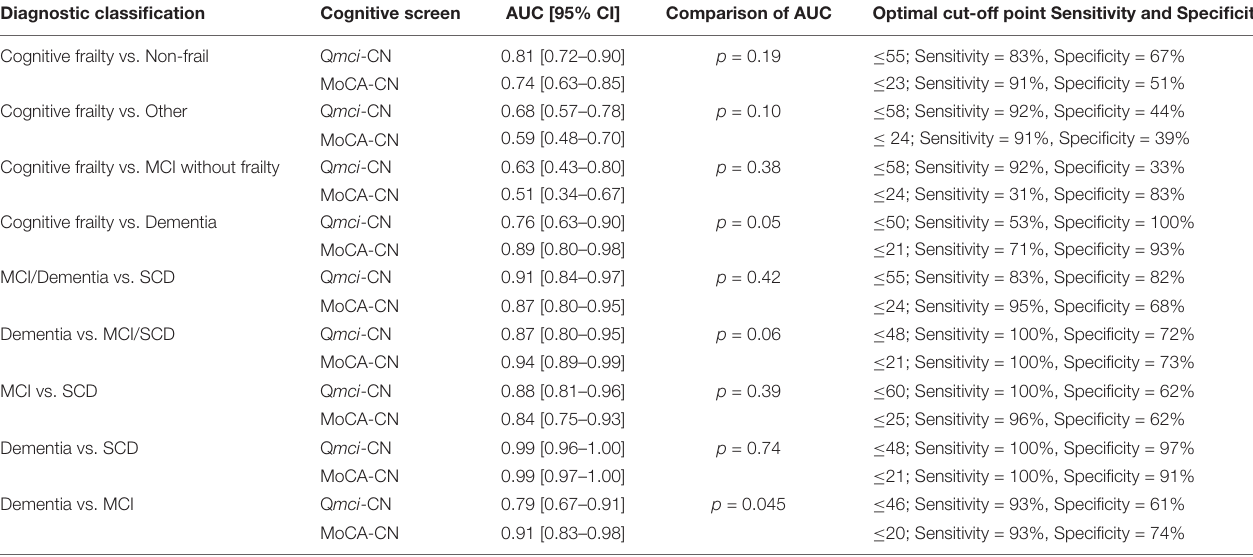
TABLE 3 | Area under the curve (AUC) values and cut-offs for the Chinese versions of the Quick Mild Cognitive Impairment (Q mci -CN) screen and Montreal Cognitive Assessment (MoCA-CN). Diagnostic classification Cognitive screen AUC [95% CI] Comparison of